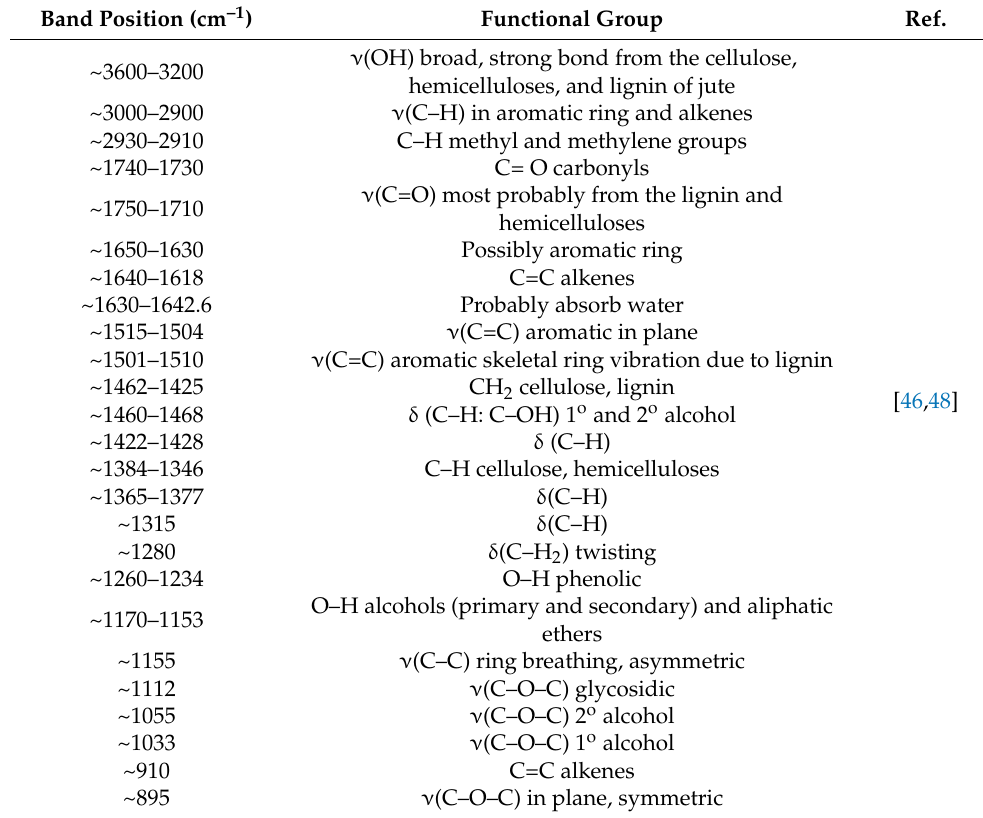
Table 3. Summary of important FTIR transmittance peaks in untreated jute